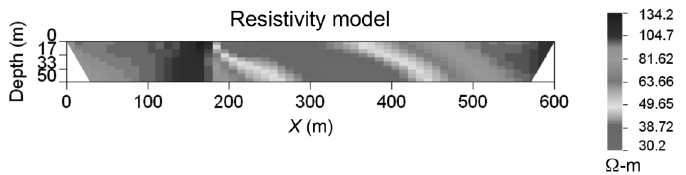
Fig. 17. Result of geophysical inversion, pdL configuration, Model 2, Scenario 2 at 700 days: recovered resis- tivity.